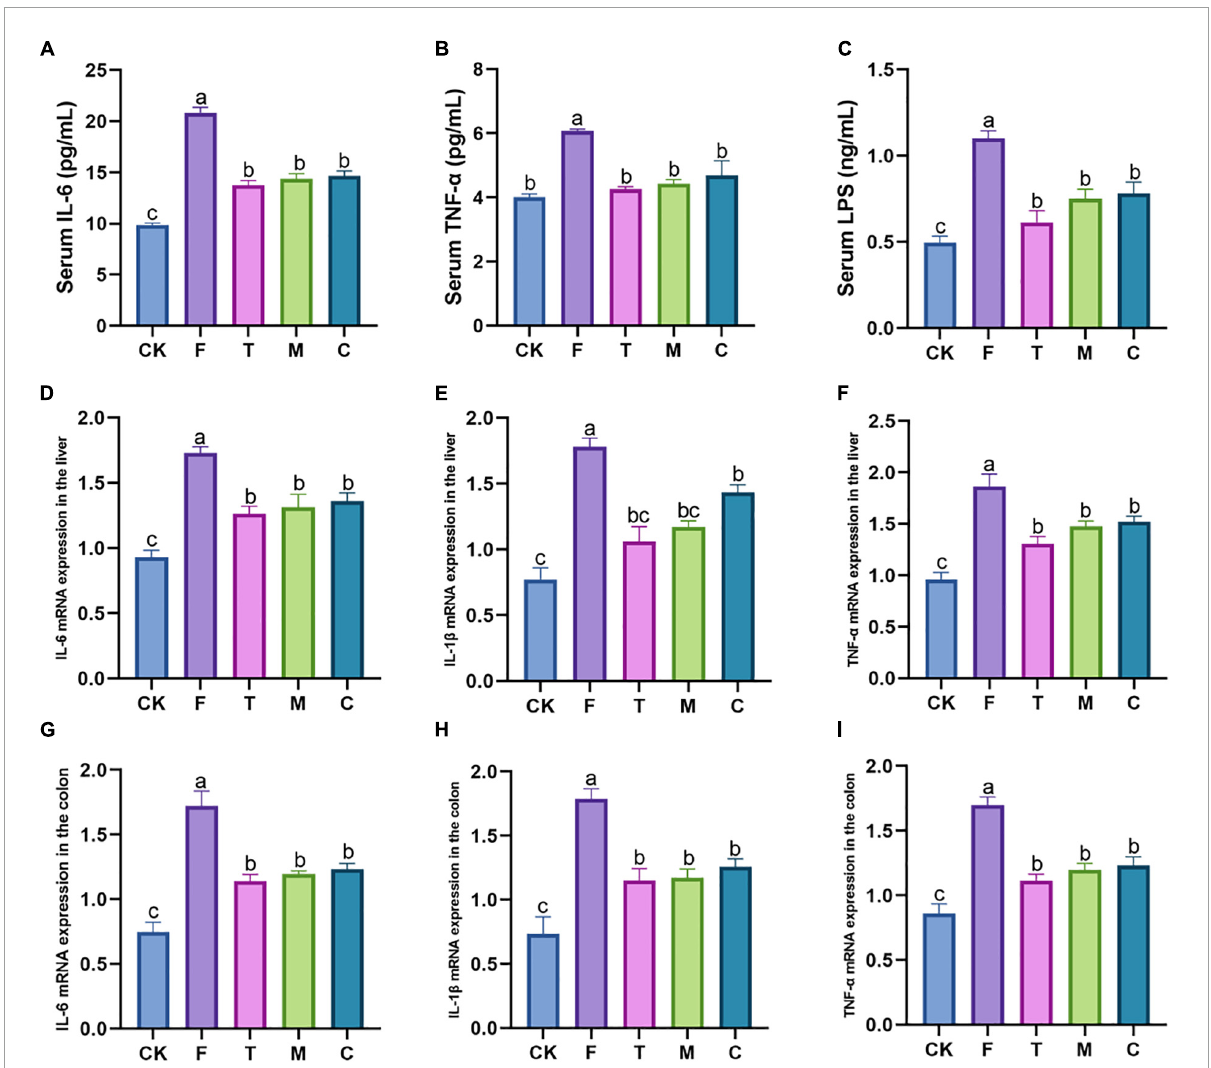
FIGURE3 Different qualities of green tea powder reduced the systemic inflammation response of high-fat diet induced obesity in mice. (A) Serum IL-6 concentrations. (B) Serum TNF- α concentrations. (C) Serum LPS concentrations. (D) IL-6 mRNA expression levels in the liver. (E) IL-1 β mRNA expression levels in the liver. (F) TNF- α mRNA expression levels in the liver. (G) IL-6 mRNA expression levels in the colon. (H) IL-1 β mRNA expression levels in the colon. (I) TNF- α mRNA expression levels in the colon. Different letters (a–c) showed significant difference ( p <